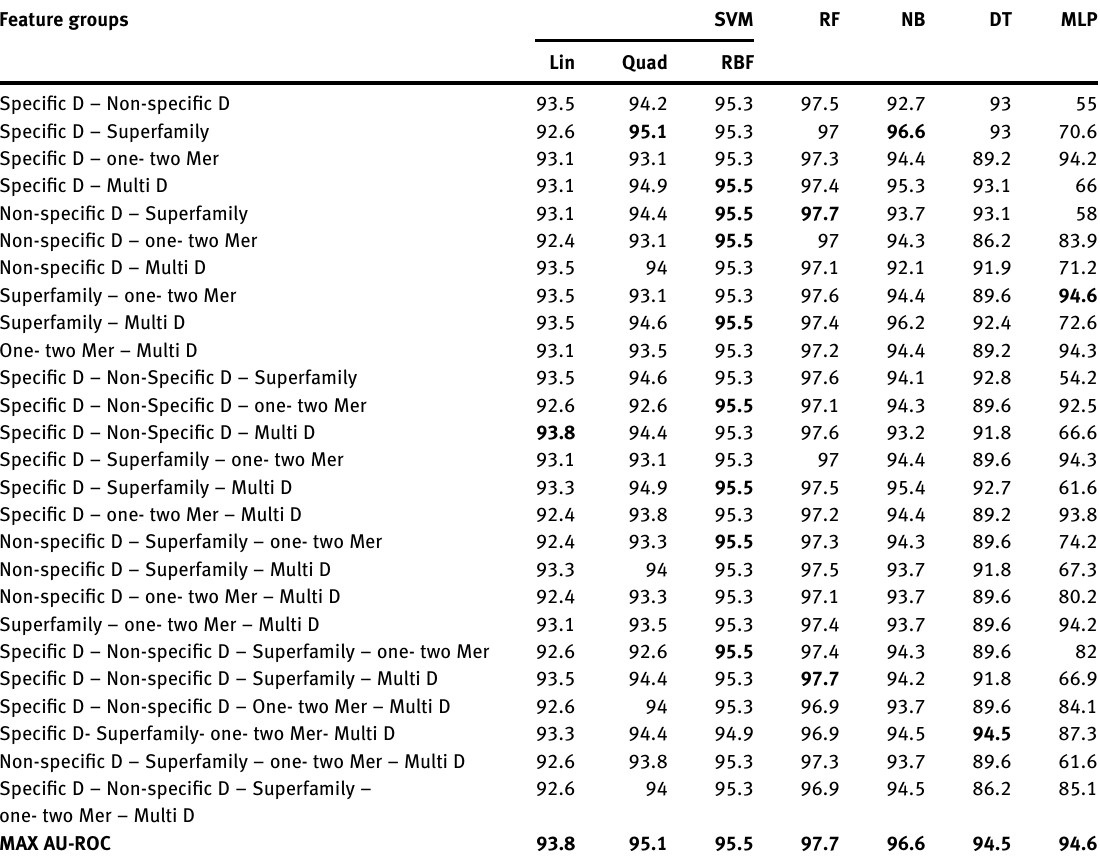
Table  : Algorithmsperformancecomparisonwithdifferentfeaturegroups(boldnumbersindicatesthebestperformanceineach column).